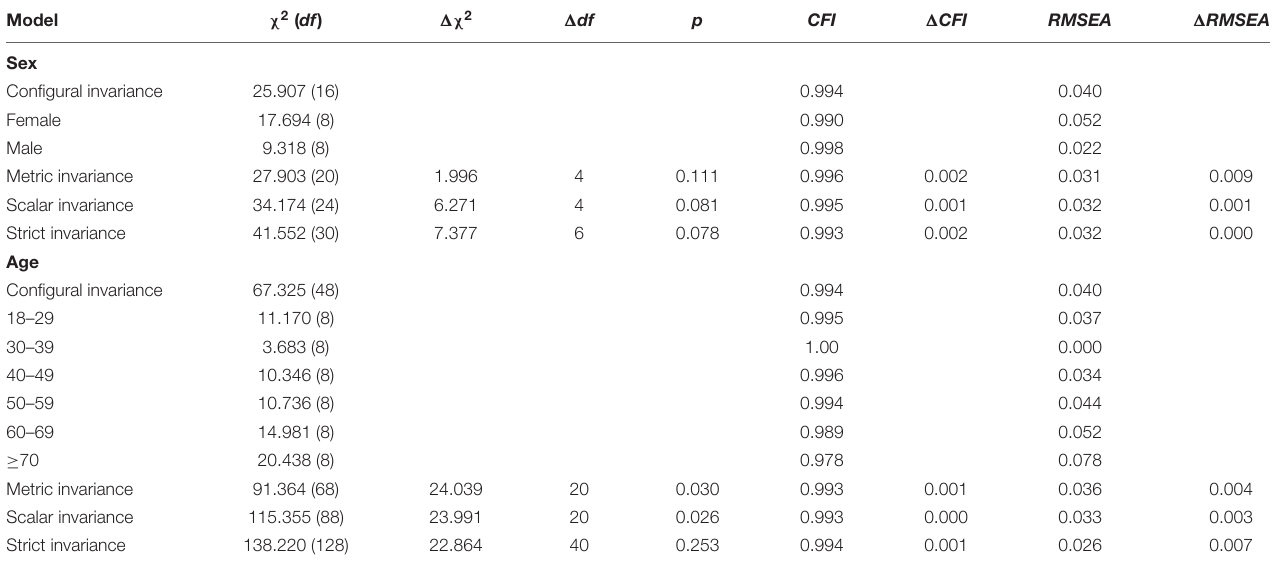
TABLE 4b | Tests of measurement invariance of the FKB-6